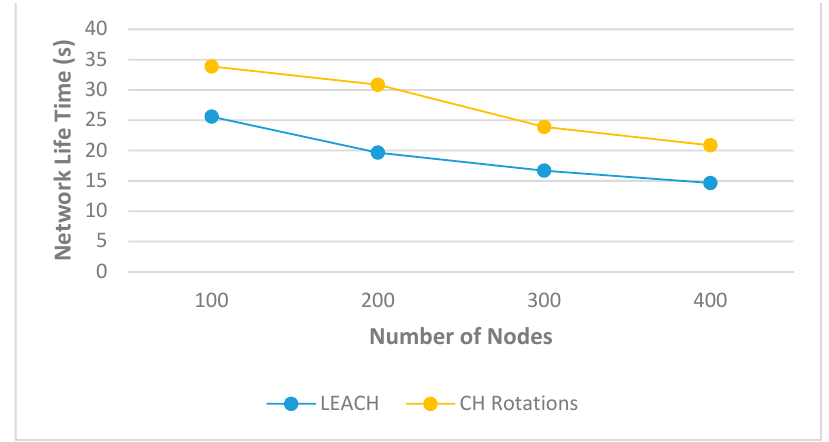
Figure 6. Analysis of the effect of WSN nodes number on the network lifetime.